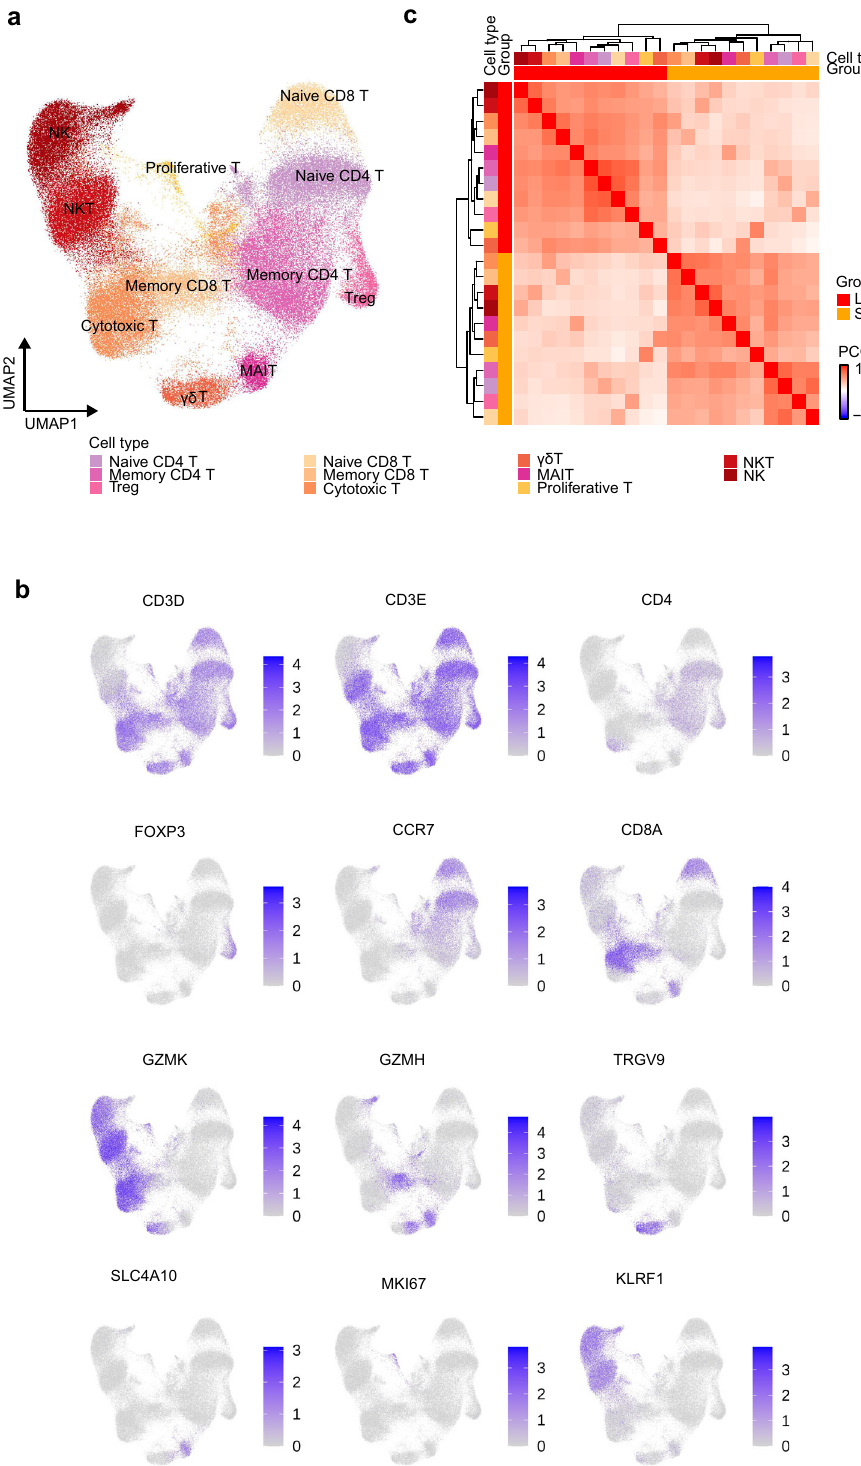
Fig. 4 Sub-clustering analysis on T and NK cells. a UMAP projection of T and NK cells. Each dot corresponds to a single cell, colored by cell type. b UMAP plot of canonical markers in 12 cell clusters. Data are colored according to log scaled expression levels. c Hierarchical clustering using the Pearson correlation coef fi cient (PCC) of a normalized transcriptome between disease groups in T and NK cells. The color intensity indicates the PCC and the color bars above the heatmap indicate the cell type and disease